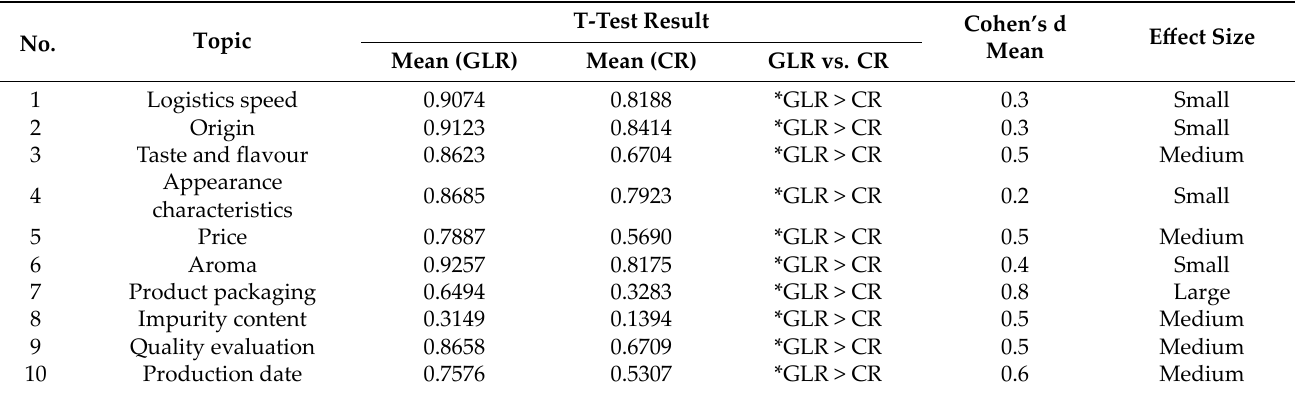
Table 6. Comparison of positive emotion probability between green‑labelled rice (GLR) and conven‑ tional rice (CR).